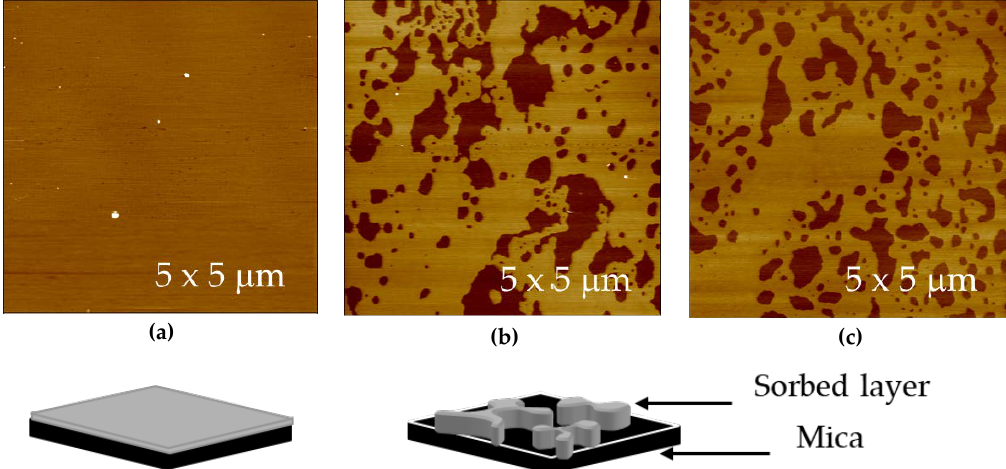
Figure 5. AFM height image of adsoeped layer on mica surface. Dark areas are mica without sorption. Bright areas are sorped layer from conditioner. ( a ) 18-MEA/SPDA. ( b ) 18-MEA/DAPS. ( c ) 18-MEA/STAC.